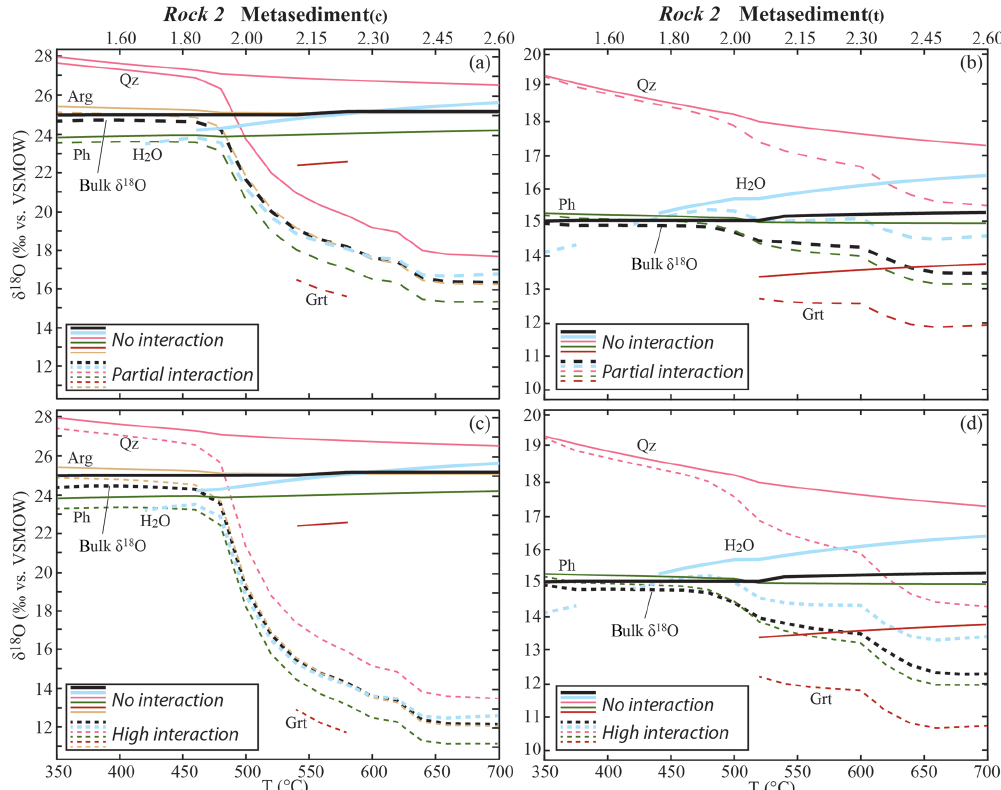
Figure 5. Calculated bulk and mineral δ 18 O values in the metasediments along the geotherm shown in Fig. 2 in the case of interaction with the metabasalt-derived fluid. Only bulk, released H 2 O and representative mineral δ 18 O values are shown for clarity. Garnet fractionation and excess fluid loss are considered. (a) Metasediment ( c ) : evolution of the δ 18 O values in the case of NI (continuous lines) and PI (dashed lines). (b) Metasediment ( t ) : evolution of the δ 18 O values in the case of NI (continuous lines) and PI (dashed lines). (c) Metasediment ( c ) : evolution of the δ 18 O values in the case of NI (continuous lines) and HI (dashed lines). (d) Metasediment ( t ) : evolution of the δ 18 O values in the case of NI (continuous lines) and HI (dashed lines). Scale on the top x axis indicates P (GPa). Mineral abbreviations are from Whitney and Evans